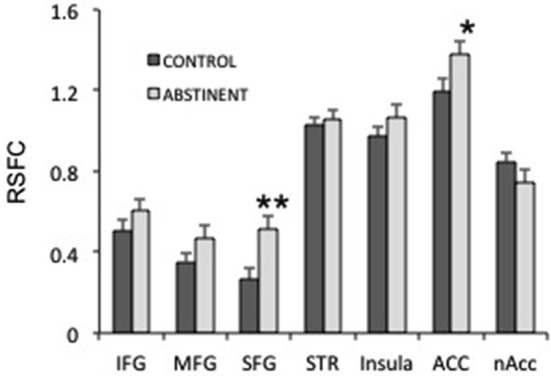
Interhemispheric resting state functional connectivity (RSFC) in several frontal regions. IFG, MFG, SFG: inferior, medial and superior frontal gyri; STR: striatum; ACC: anterior cingulate cortex; nAcc: nucleus accumbens. **puncorrected < 0.005; *puncorrected < 0.05.